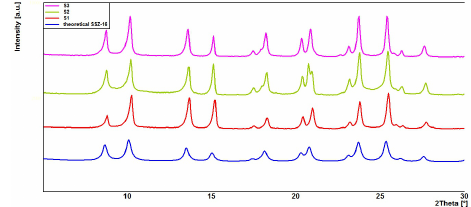
Figure 7. XRD spectra of selected samples and theoretical spectrum of